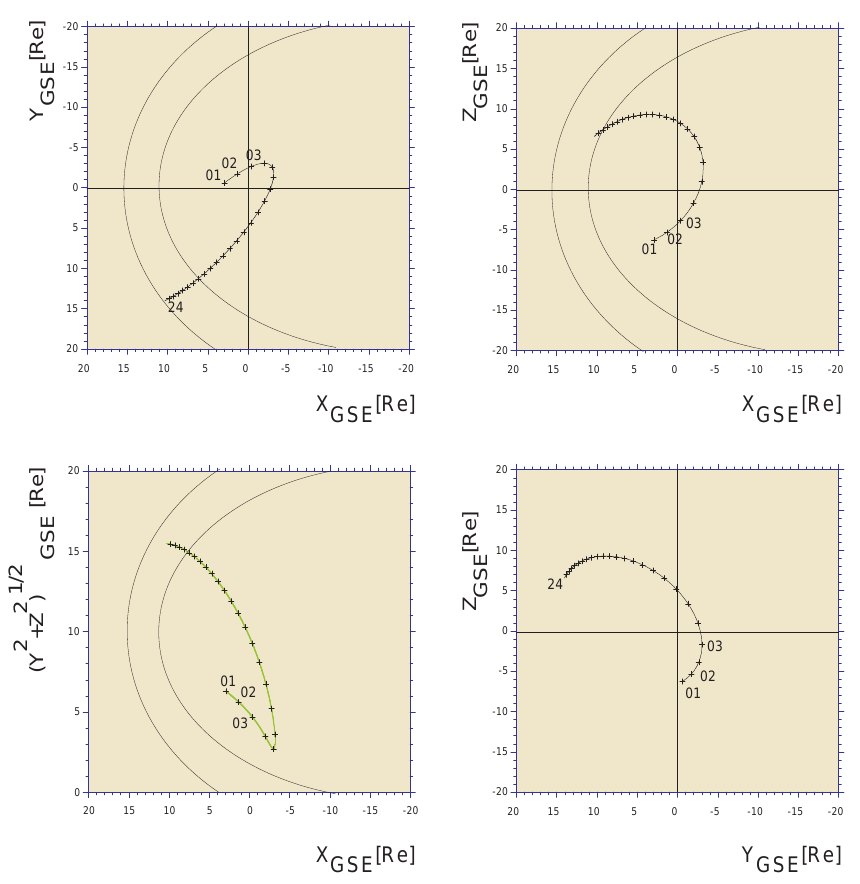
Fig. 3. The orbit of the Cluster fleet on 14 January 2001. The tick marks denote the spacecraft position in intervals of one hour.